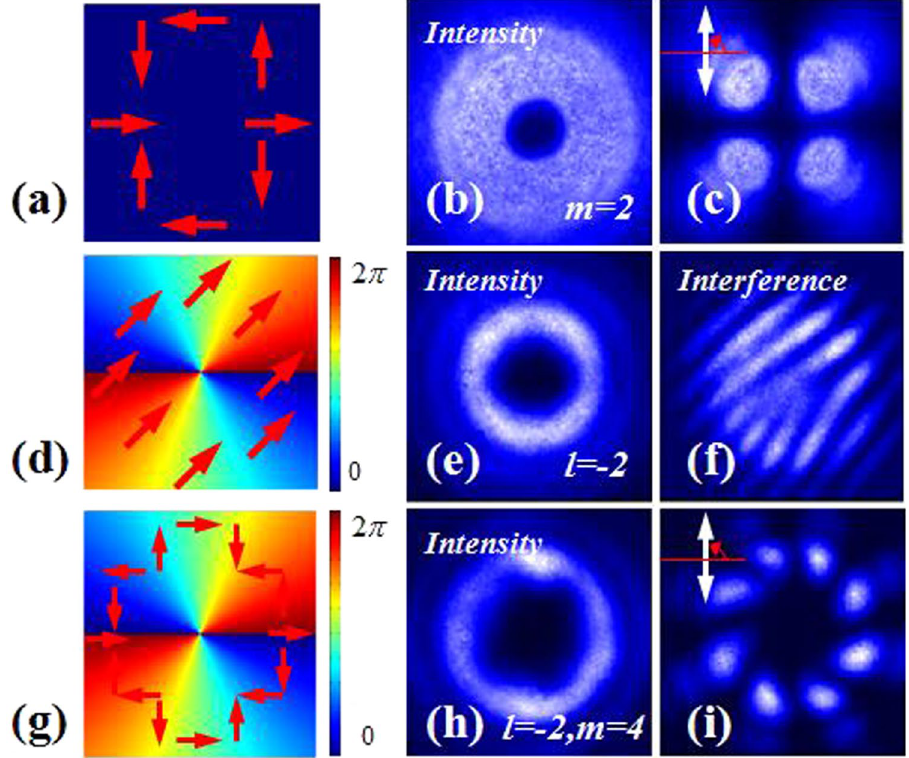
Figure 11. The intensity profiles and analyzed patterns of the singularity beams obtained by the above system. The polarization order ( m ) of the CVB (at point a ) is 2, the topological charge ( l ) of the converted VB (at point b ) is − 2, the polarization order and the topological charge of the generated CVV beam (at point c ) is 4 and − 2, respectively. The first column shows the schematic polarization distributions (red arrow diagrams) and phase distributions (periodically changing color background), of which the experimental results are presented in each row respectively. The axis orientations of polarizer 90 0 (white arrows in the top left corner) was selected in the analysis of CVB and CVV beam. The VB is analyzed by interfering with a plane